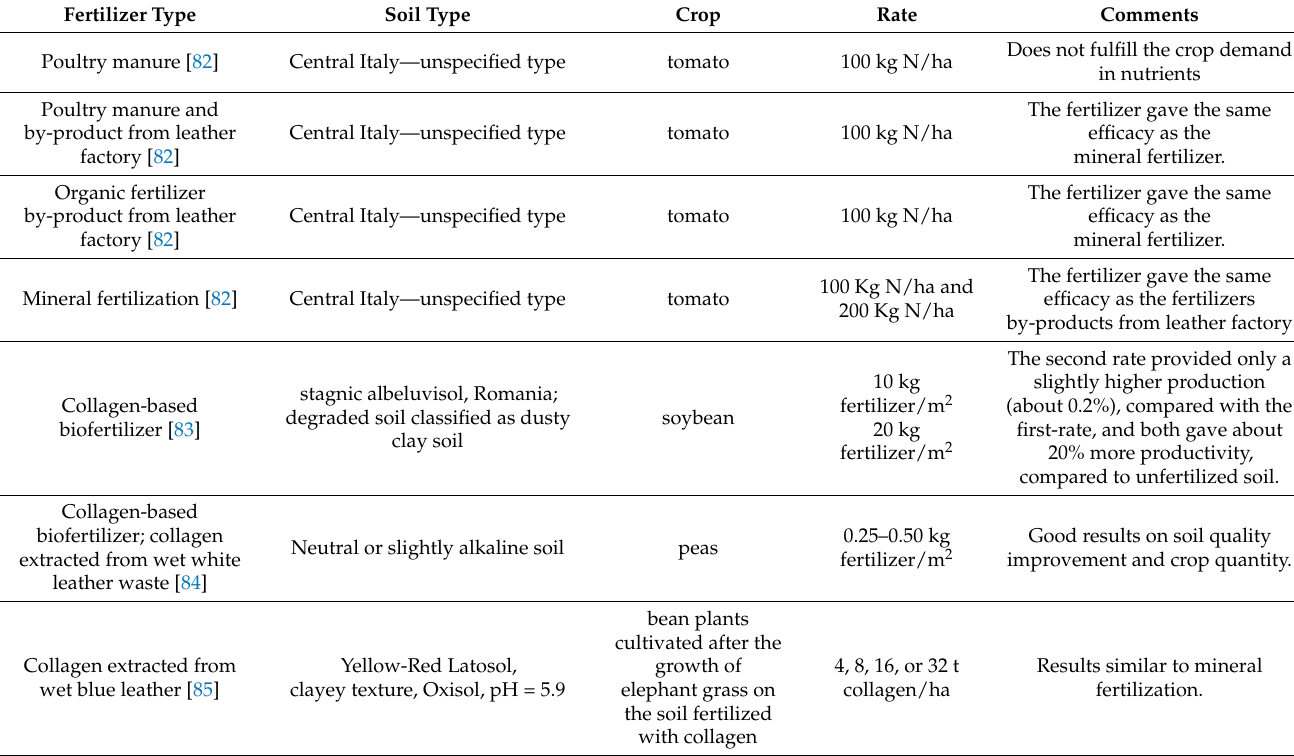
Table 1. Comparison between different biopolymer-based fertilizers obtained from leather